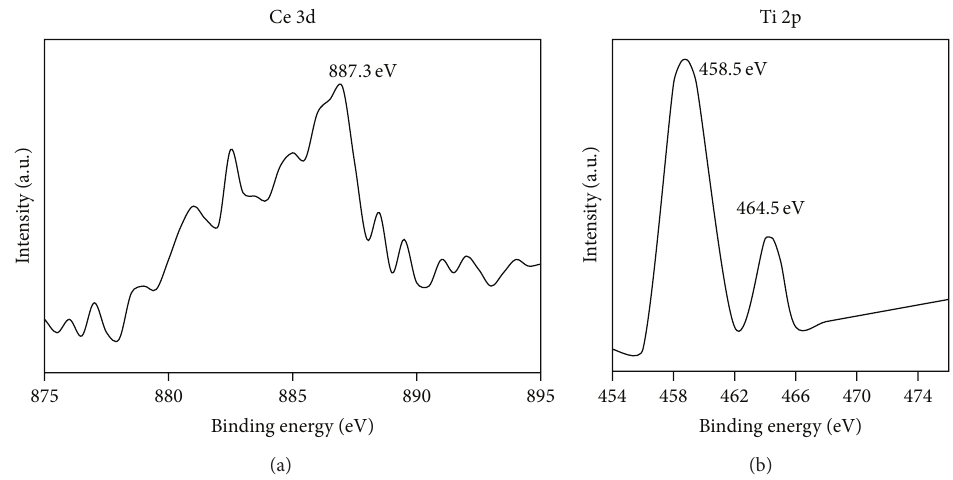
Figure 2: XPS analysis of TiO 2 -Ce doped catalyst.